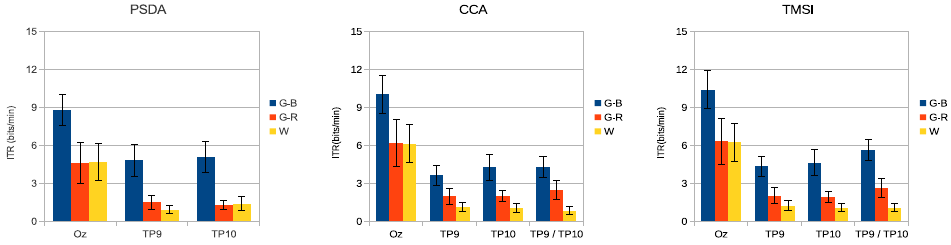
Figure 9. Average ITR of all volunteers for the three stimuli for the high-frequency range. Error bars indicate standard